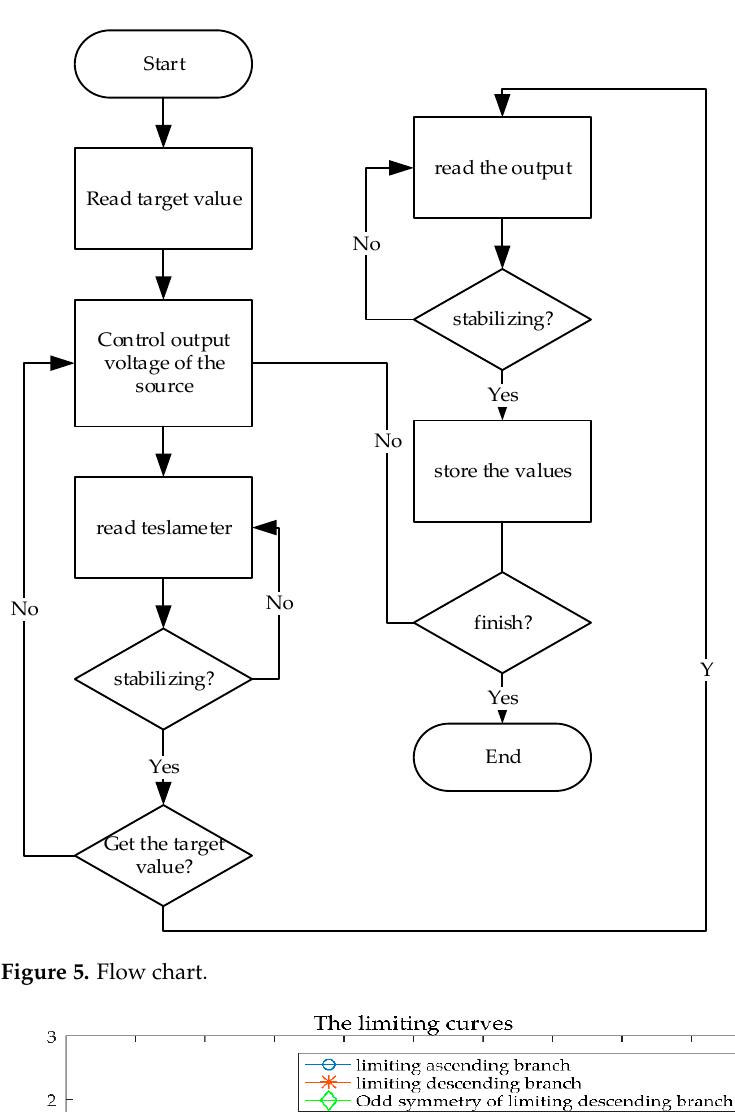
Figure 5. Flow chart.